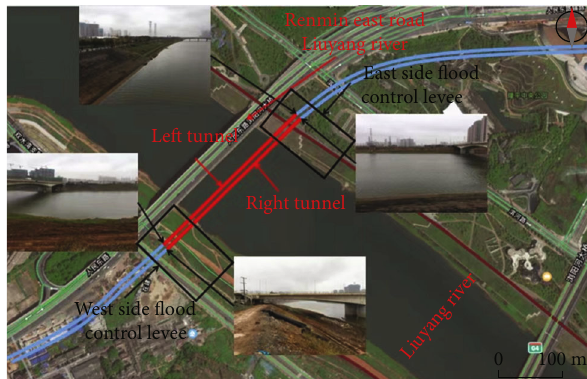
Figure 1: Aerial view of the subway line (the blue line is the conventional subway line, and the red line is the subway line crossing the fl ood control levee and Liuyang